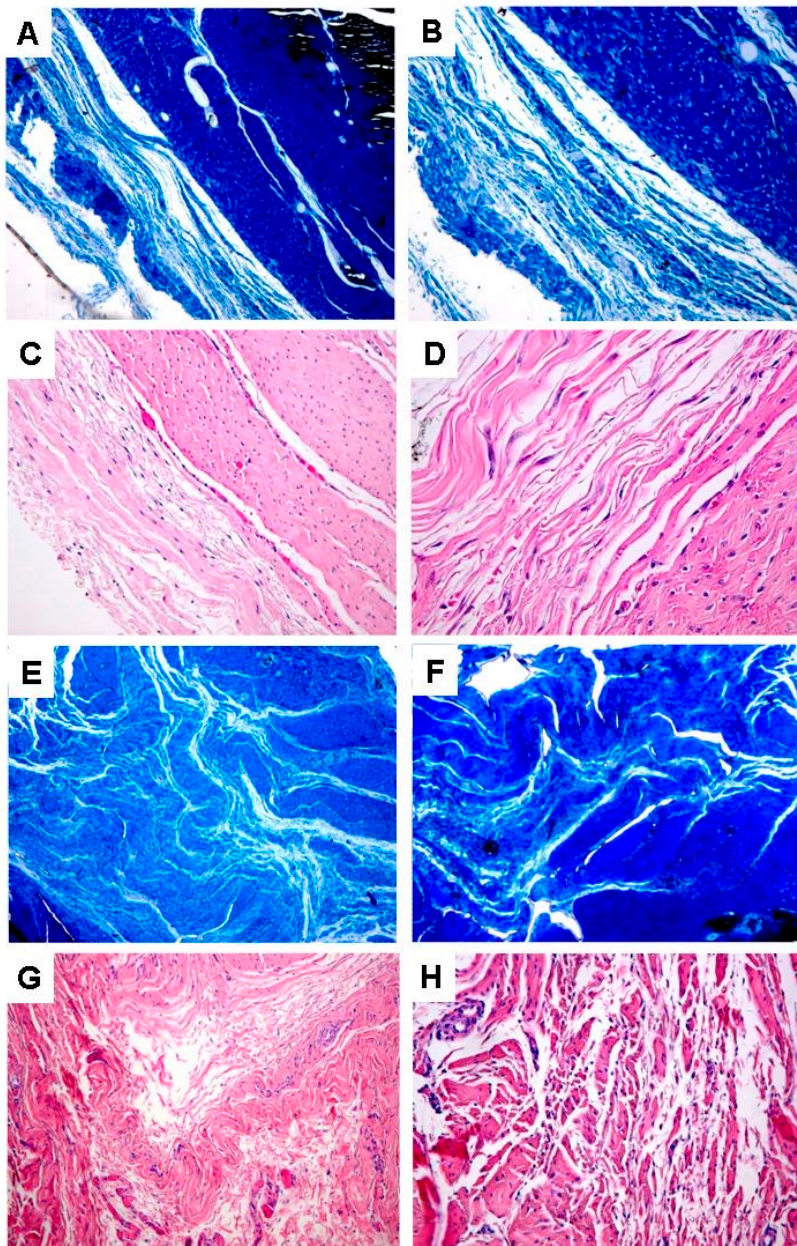
Figure 3. High magnification light microscopy analysis following Masson’s Trichrome ( A , B , E , F ) and Hematoxylin and Eosin ( C , D , G , H ) staining. ( A – D ) Hyaloglide ® group. ( E – F ) Control untreated group. Magnification: ( A , C , E , G ) = 400X; ( B , D , F , H ) =